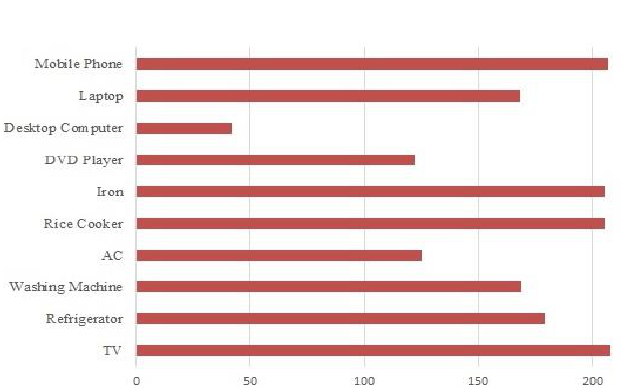
Fig. 2: Penetration of electronic products